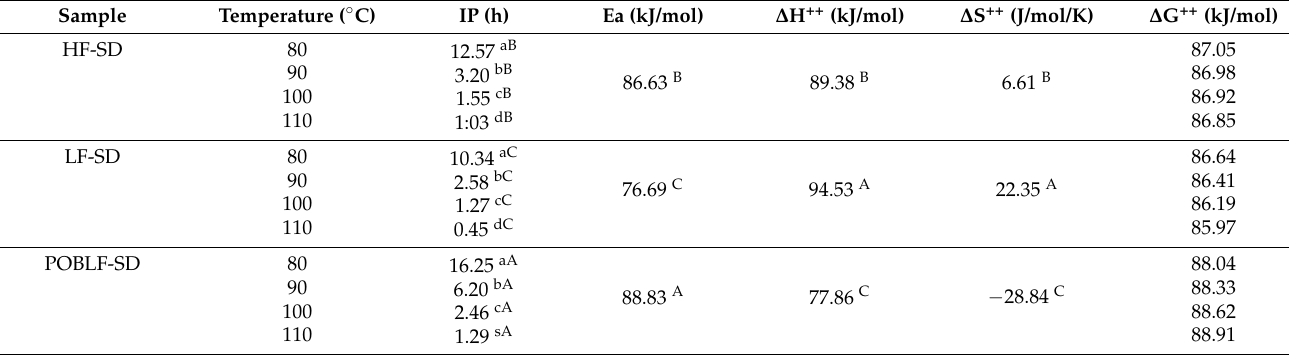
Figure 7. Light microscopy pictures of HF-SD ( a ), POBLF-SD ( b ), and LF-SD ( c ) (HF-SD: high-fat salad dressing sample; LF-SD: low-fat salad dressing sample; POBLF-SD: low-fat salad dressing sample with cold-pressed pumpkin seed oil by-product). Table 6. The oxidation kinetic parameters of the salad dressing